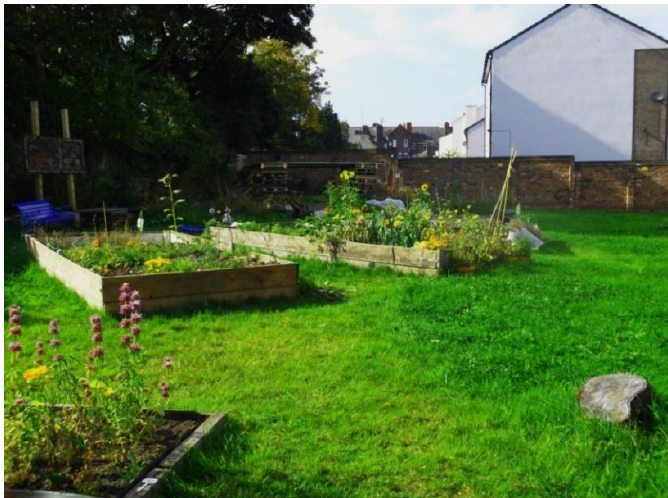
Figure 4. Example of a community garden promoting respect and social inclusion (P3) (Ferngrove community garden, Liverpool).